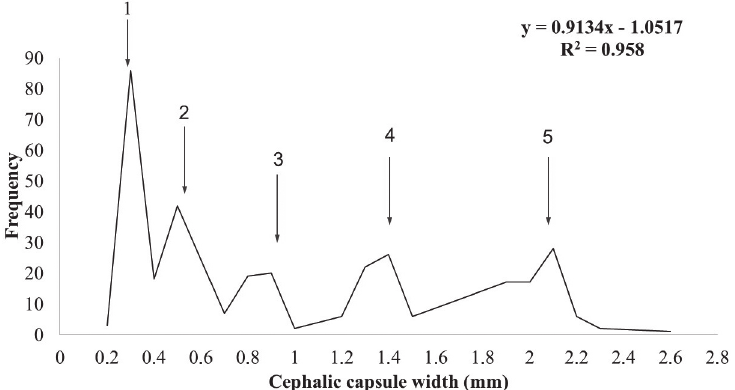
Figure 1 - Larval instar number of Condylorrhiza vestigialis and the cephalic- capsule widths on the corn, wheat germ and yeast-based Diet 3. Temperature 25 ±